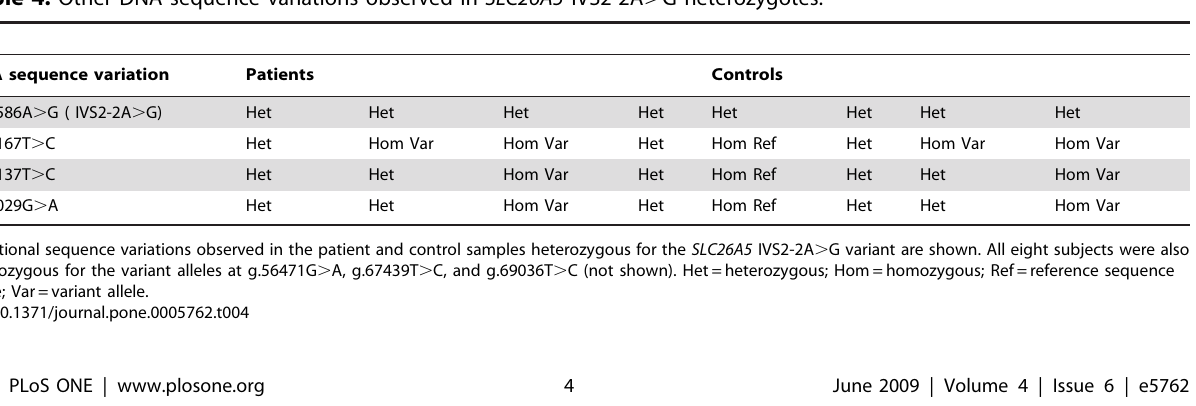
DNA sequence variation Patients